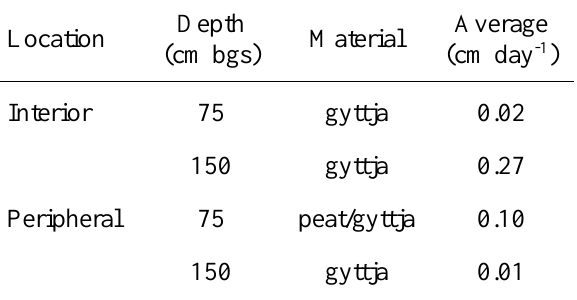
Table 1: Field saturated hydraulic conductivity (4 study season geometric mean from 8